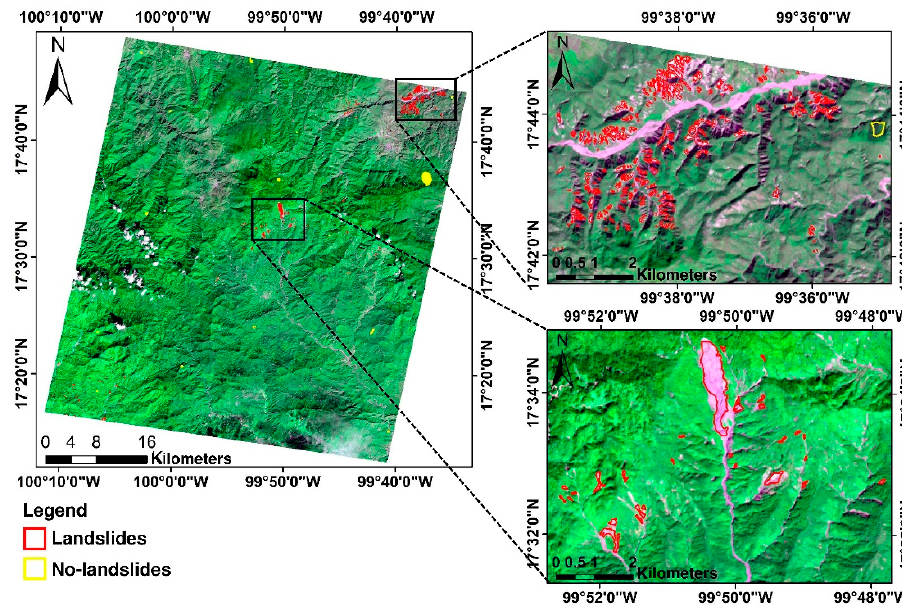
Figure 8. Location and distribution of ground-truth.